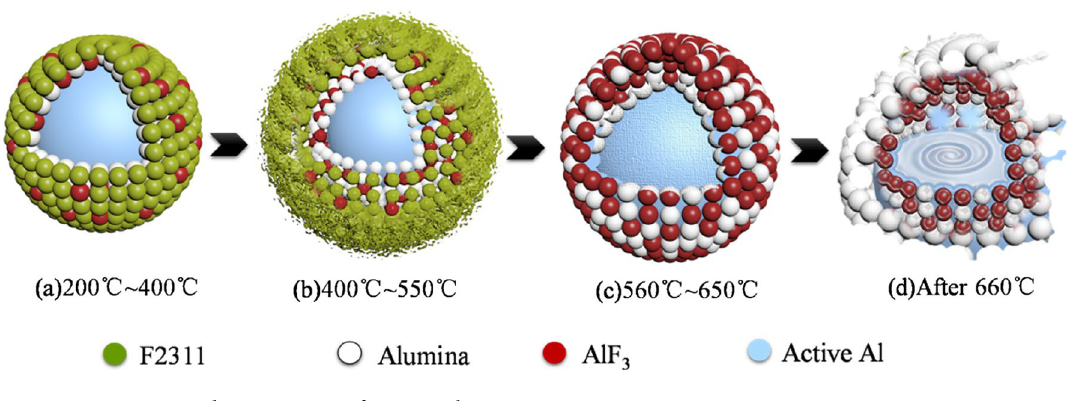
Figure11. Oxidation reaction of